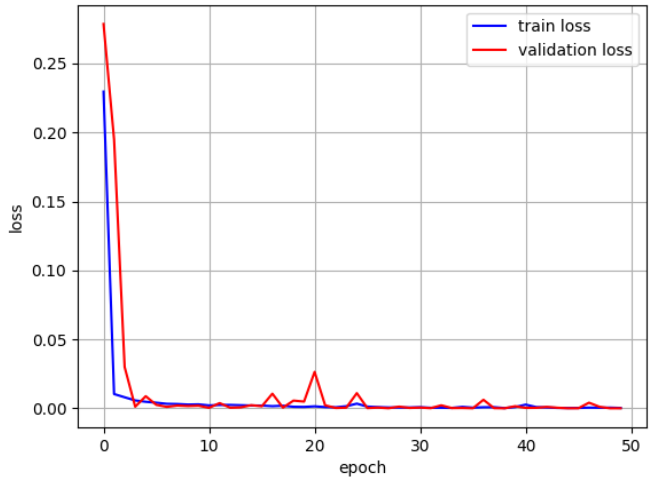
Figure 4. Comparison diagram of loss value of training set and verification set.